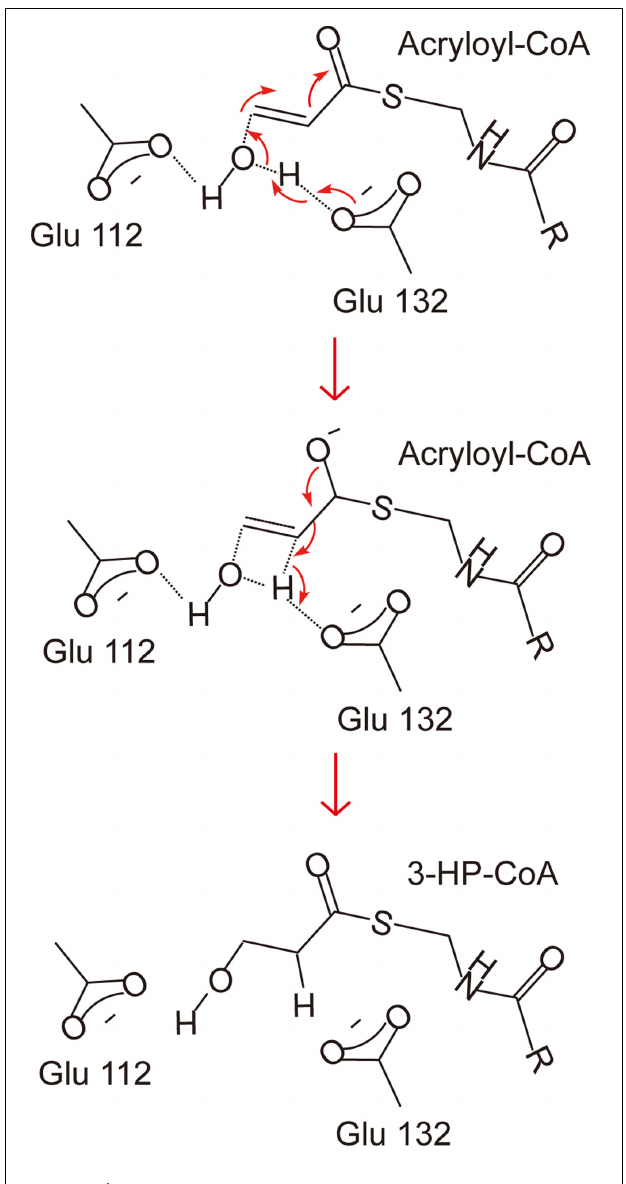
FIGURE 7 | A proposed catalytic mechanism of Rd AcuH. The two residues, Glu112 and Glu132, play important roles in the reaction. They would be ionized under a neutral condition. Firstly, Glu132 acts as the brønsted base and transfers an electron to the water molecule. Then the activated water molecule attacks the C 3 atom of acryloyl-CoA and the transition state is formed. Finally, the redundant electron is transferred to Glu132, the water molecule is added to acryloyl-CoA and 3HP-CoA is